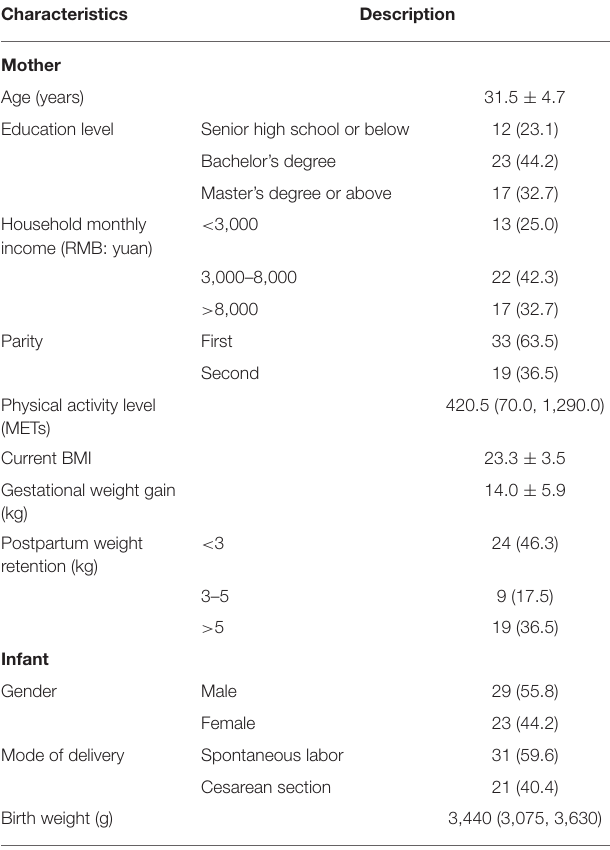
TABLE 1 | Basic characteristics of the 52 pairs of mother and infant.